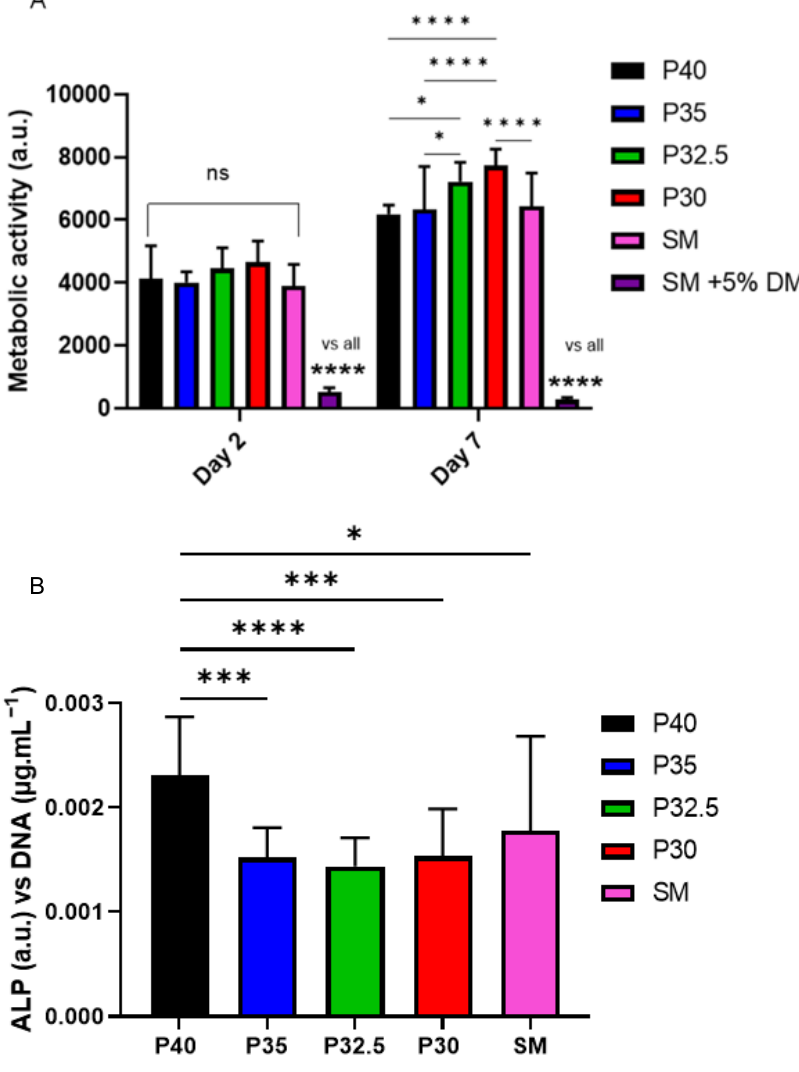
Figure 8. ( A ) Evaluation of cell metabolic activity in indirect culture of porous microspheres at day 2 and day 7. * p < 0.05 and **** p < 0.0001. ( B ) Evaluation of ALP activity in indirect culture with porous microspheres at day 7. * p < 0.05, *** p < 0.001 and **** p < 0.0001.